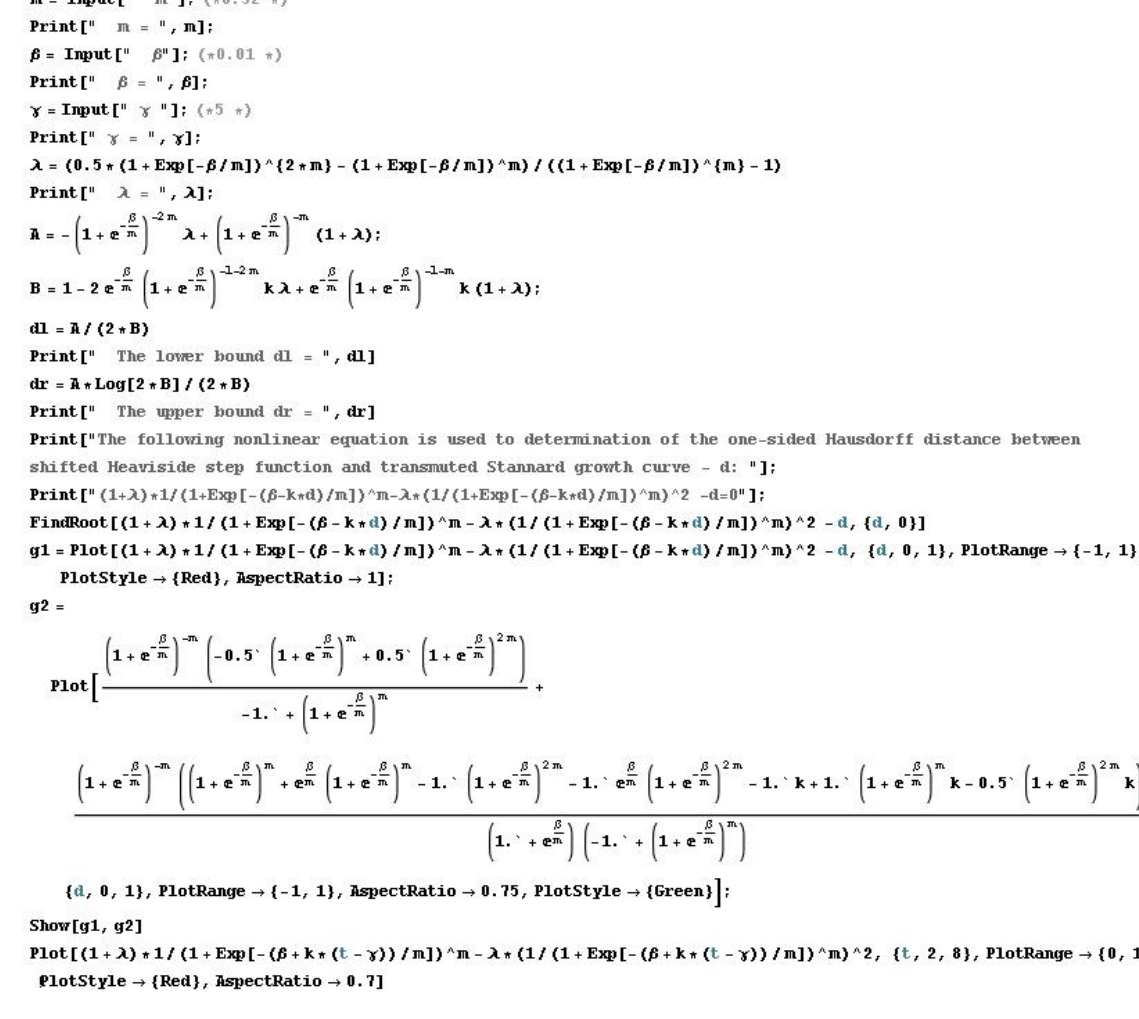
Fig. 4. A simple module implemented in CAS Mathematica for the computation and visualization of the Hausdorff distance between the Heaviside step function and the transmuted Stannard growth